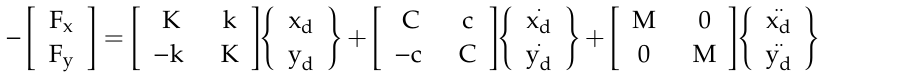
- Figure 3. Grid independency analysis. 3.2. Mesh Movement Due to the circle orbit whirl model of the rotor as mentioned in Section 2, the shape of the fluid domain changes with time, which needs a transient CFD method to deal with it. To perform the transient CFD computations, the dynamic mesh problem should be solved. In this work, the dynamic mesh is achieved by applying a user-defined subroutine linked with FLUENT solver to strictly control the motion of every grid node in the seal model. The specific implementation procedures are as follows. Figure 4 shows a cross-section view of a simplified plain seal at an arbitrary axial position. As illustrated in the figure, the seal clearance C r has been exaggerated, C 1 represents the current eccentric position where the rotor moves from concentric position marked C 0 , d (x d , y d , 0) denotes the moving distance of the rotor in Cartesian coordinates. When the rotor is at the concentric position, P i0 represents an arbitrary node in the clearance of the seal and is assumed to project along a mesh line that connects one node P r0 on the rotor surface and another P s0 on the stator surface. After the rotor moves by d, the movement displacements of the nodes on the rotor surface are also d. Therefore, the new coordinates (x r1 , y r1 ) of P r0 are defined as Equation (4).